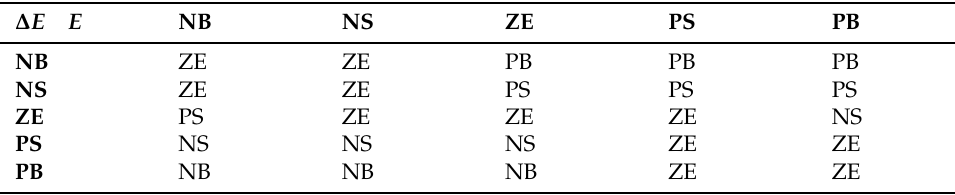
Table 1. Rule base of FLC with the inputs E and ∆ E and the output ∆ D .